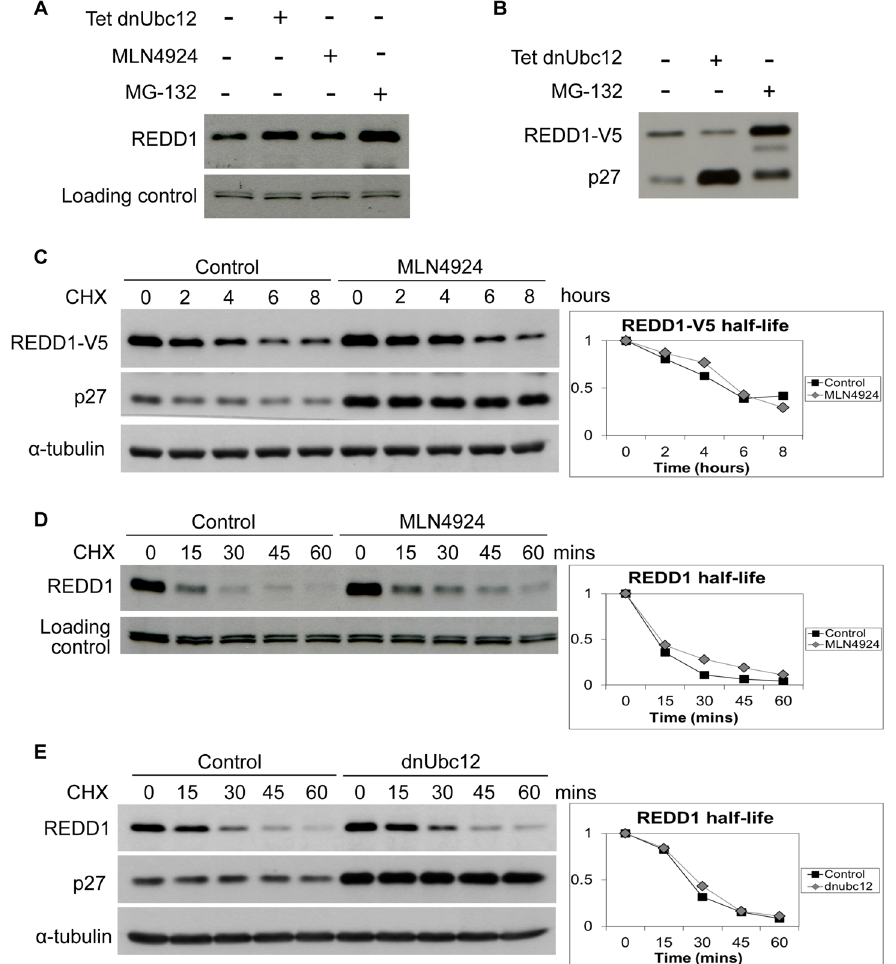
Figure 4. REDD1 is not regulated by Cullin E3 Ubiquitin ligases. ( A , B ) Untransfected ( A ) or REDD1-V5 pcDNA3 (0.3 m g) transfected ( B ) HEK293 cells stably expressing tetracycline inducible dnUbc12-HA were induced with 1 m g/ml tetracycline for 24 hours ( A , B ) or treated with 3 m M MLN4924 ( A ) or 20 m M MG-132 ( A , B ) for 8 hours followed by cell lysis. ( C , D ) Untransfected HEK293 ( C ) or HEK293 transfected with REDD1-V5 pcDNA3 (0.3 m g) ( D ) were pre-treated with 3 m M MLN4924 followed by cycloheximide (40 m M) treatment and cell lysis at the indicated time points. ( E ) HEK293 cells stably expressing tetracycline inducible dnUbc12-HA were induced with 1 m g/ml tetracycline for 24 hours followed by cycloheximide (40 m M) treatment and cell lysis at the indicated time points. stability of REDD1 mutant compared to controls (Figure 5D).